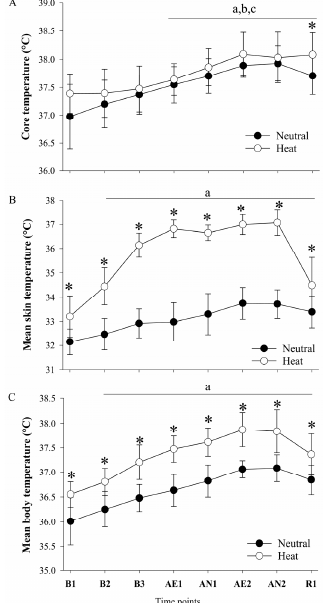
Figure 2. (A) Core temperature (B) mean skin temperature, and (C) mean body temperature